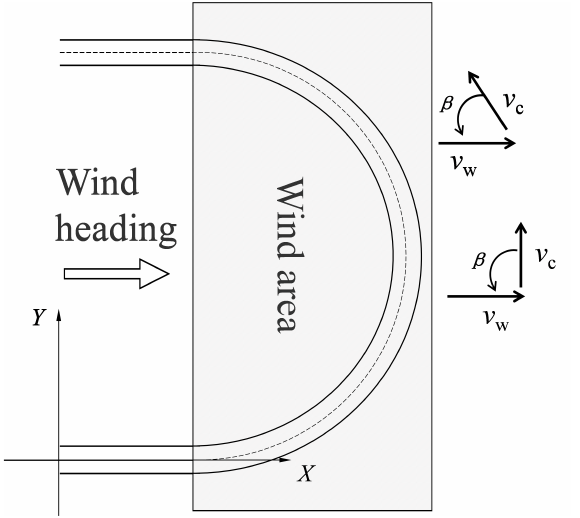
Figure 5. Road and crosswind models for curved slope sections.